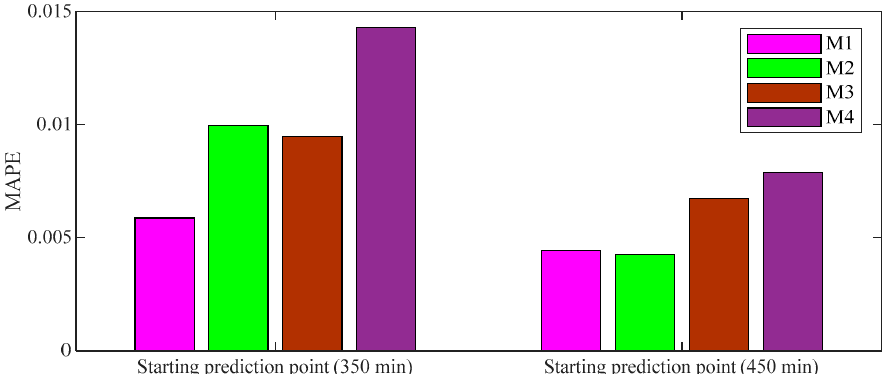
Figure 16. Different prediction starting points (350 min and 450 min) under the evaluation index